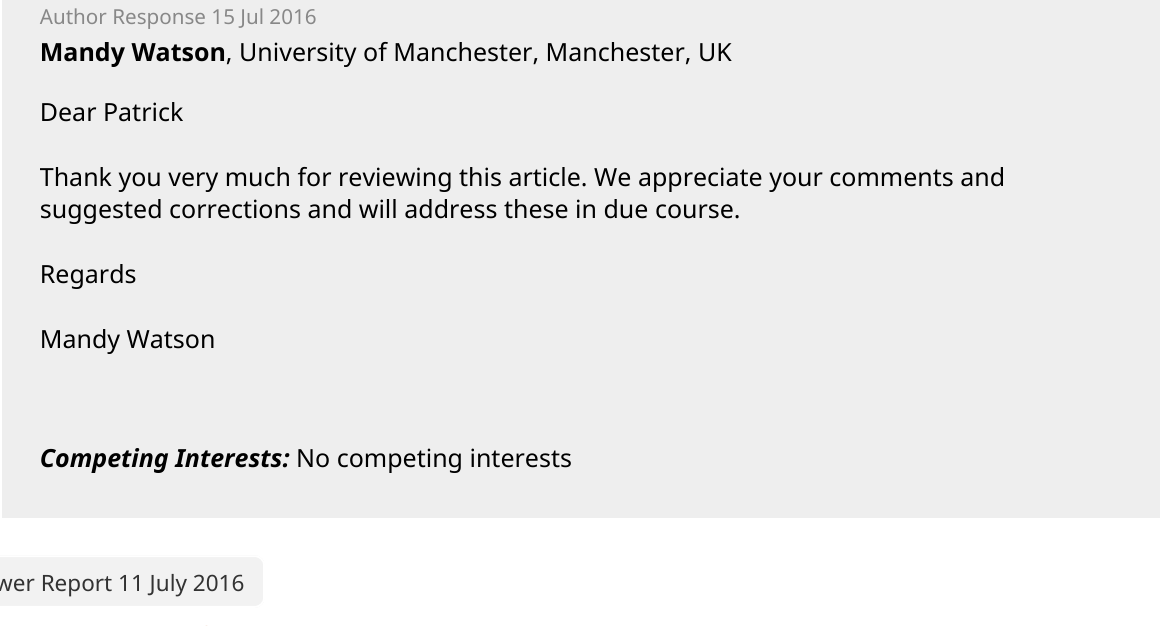
Challenging to distinguish between red and orange, how about another colour? Which cell line is this data from? Supplementary Figure